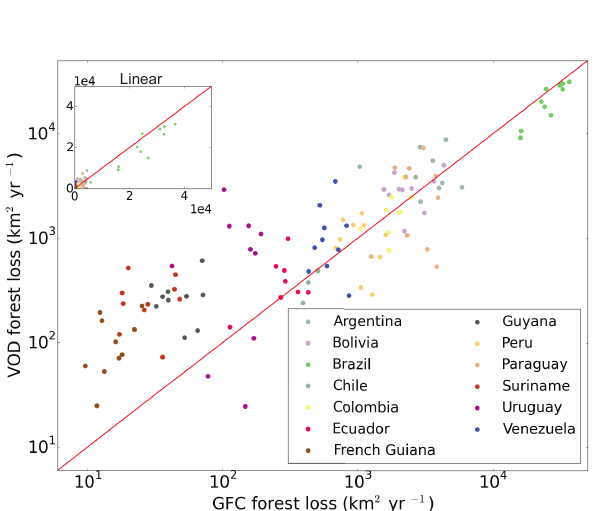
Figure 6. Country-level comparison of calibrated VOD and GFC forest loss based on annual totals (2001–2010). The inset shows the same data on a linear scale. The red lines depict the 1 : 1 line.